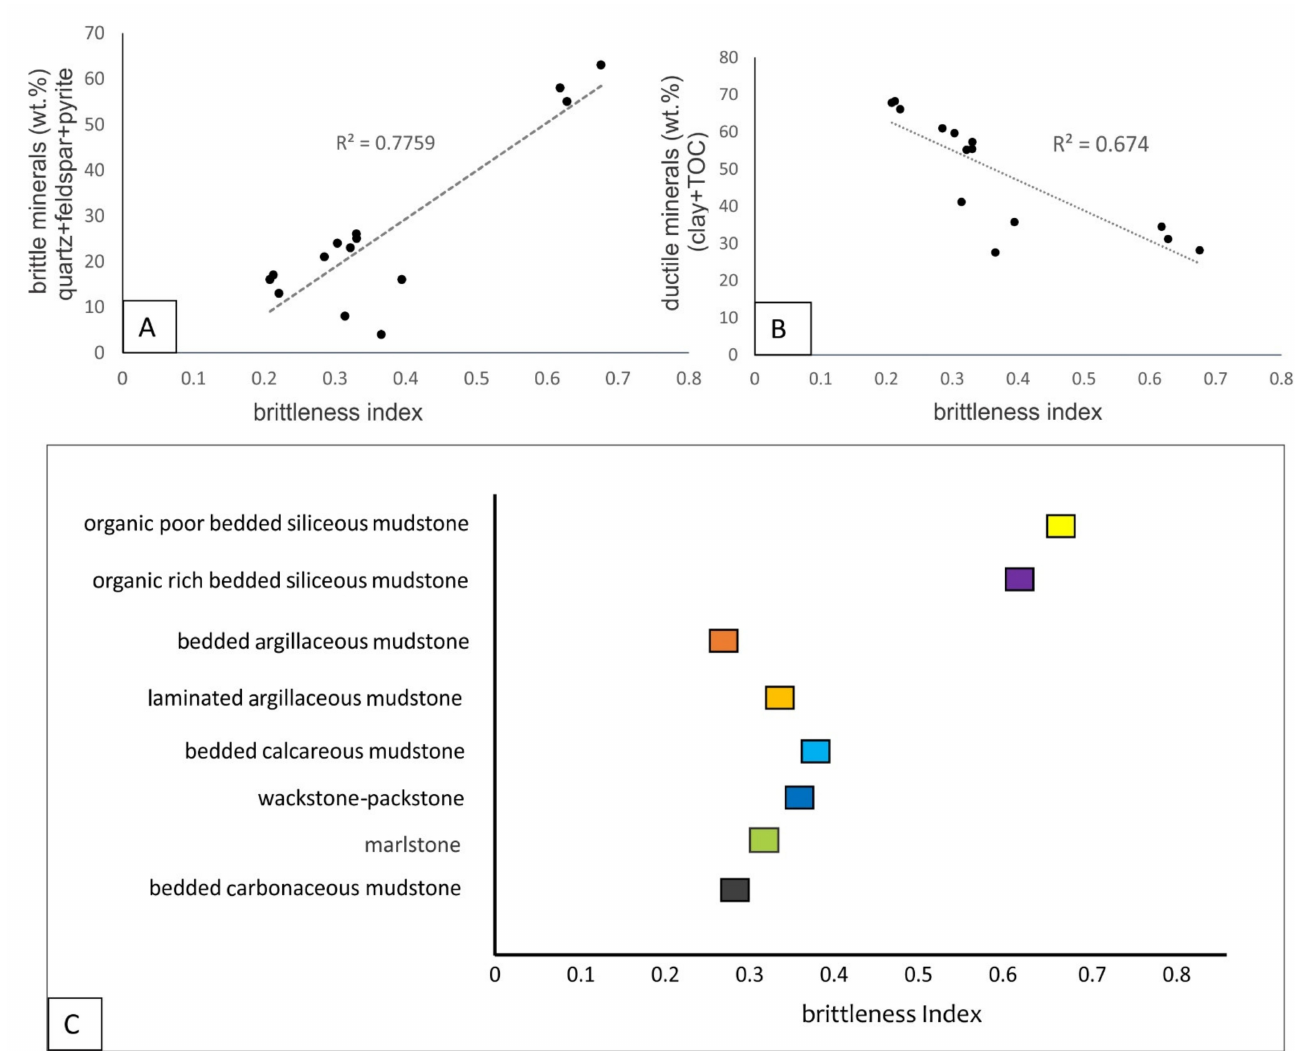
Figure 9. ( A ) Relationship between brittleness index and brittle minerals in the rock matrix. ( B ) Relationship between brittleness index and ductile minerals in the rock matrix. ( C ) Summary diagram showing the distribution of mudstone lithofacies into ductile, less brittle, and brittle zones on the basis of respective brittleness